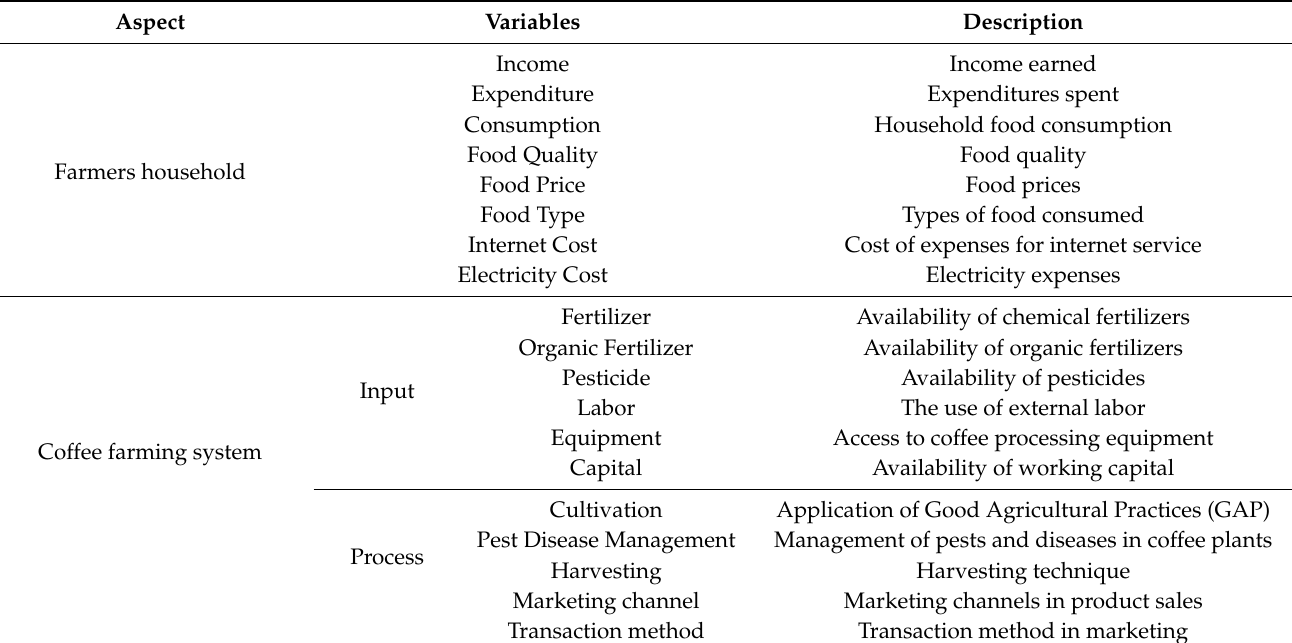
Table 1. Variables of